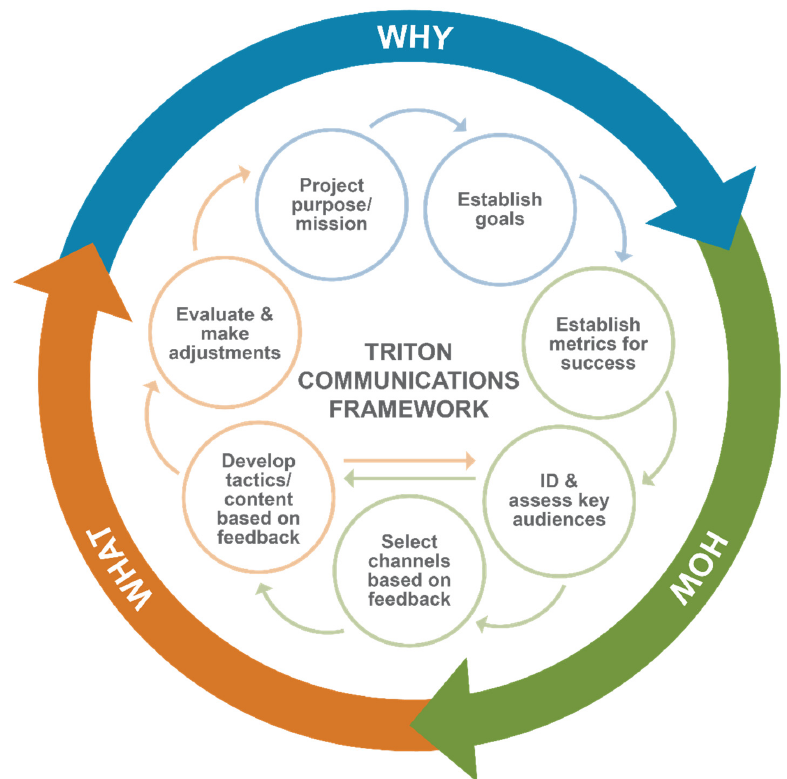
Figure 1. Triton communications framework for developing strategic communications content to support research project mission and communication goals. (Diagram by Stephanie King, Pacific Northwest National Laboratory.)